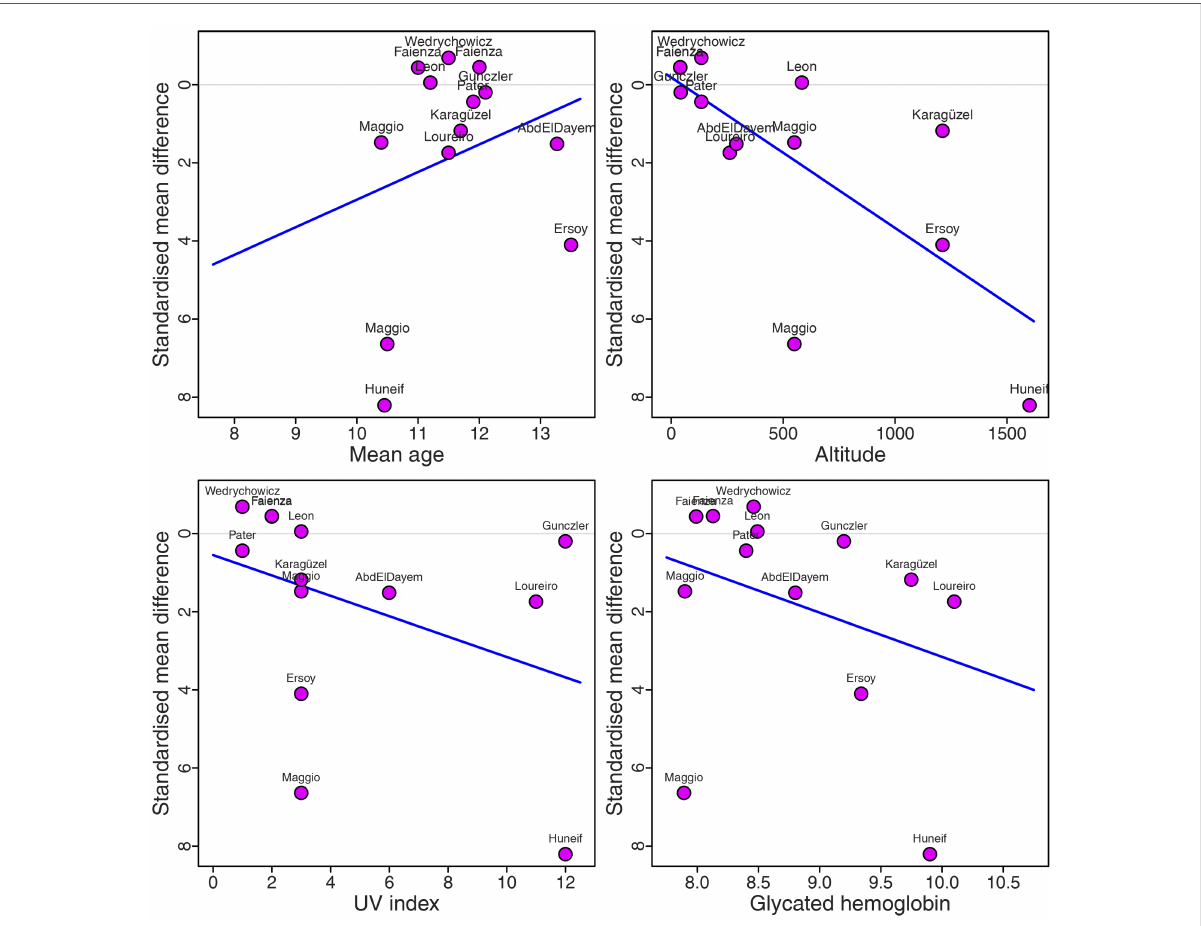
FIGURE 6 Meta-regressions showing variables in fl uencing the serum levels of tOC in pediatric patients: ( A ) mean age. ( B ) Altitude. ( C ) UV index. ( D ) Glycated hemoglobin.